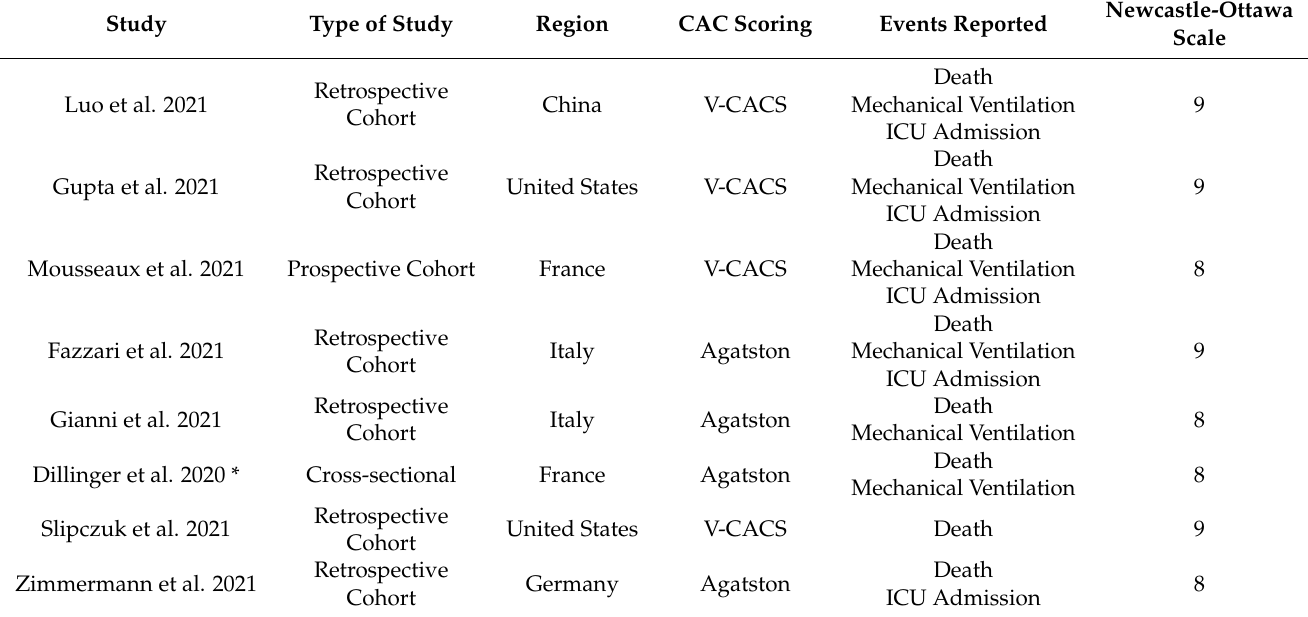
Table 1. Summary of study characteristics.